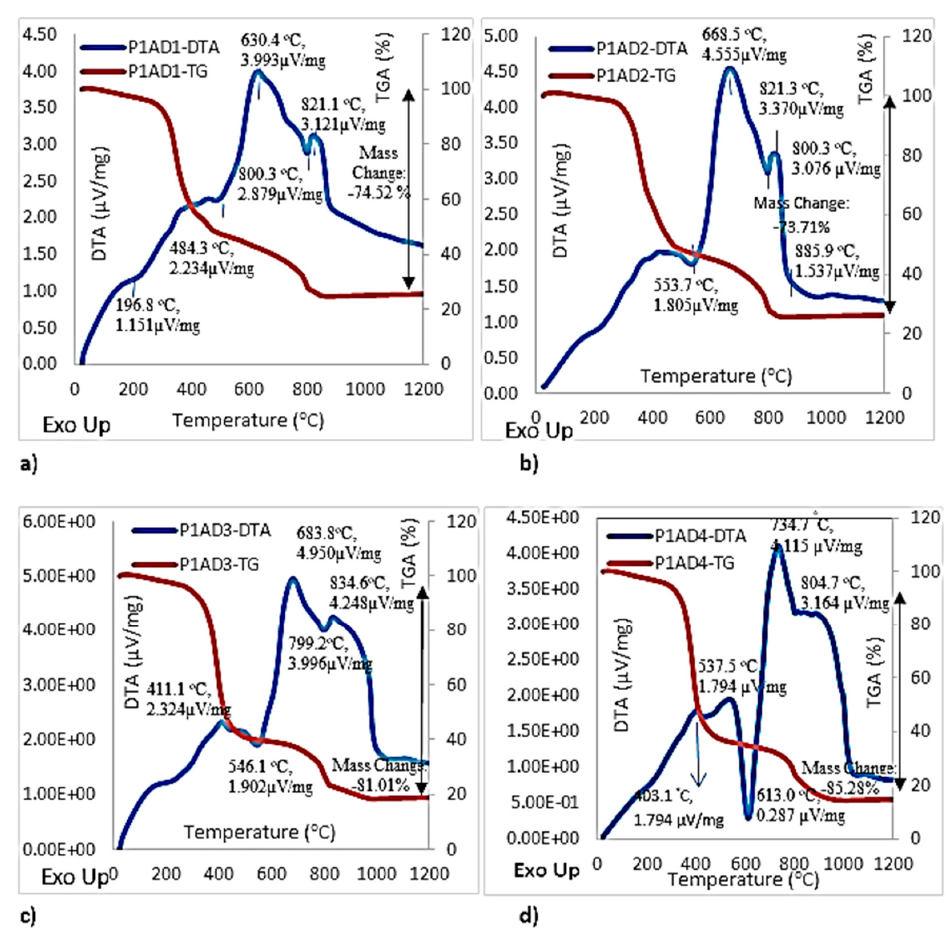
Figure 7. Di ff erential thermal analysis (DTA) / thermogravimetric analysis (TGA) of adhesives ( a ) 1, Figure 7. Differential thermal analysis (DTA)/thermogravimetric analysis (TGA) of adhesives ( a ) 1, ( b ) 2, ( c ) 3 and ( d ) 4 from phase 1. ( b ) 2, ( c ) 3 and ( d ) 4 from phase